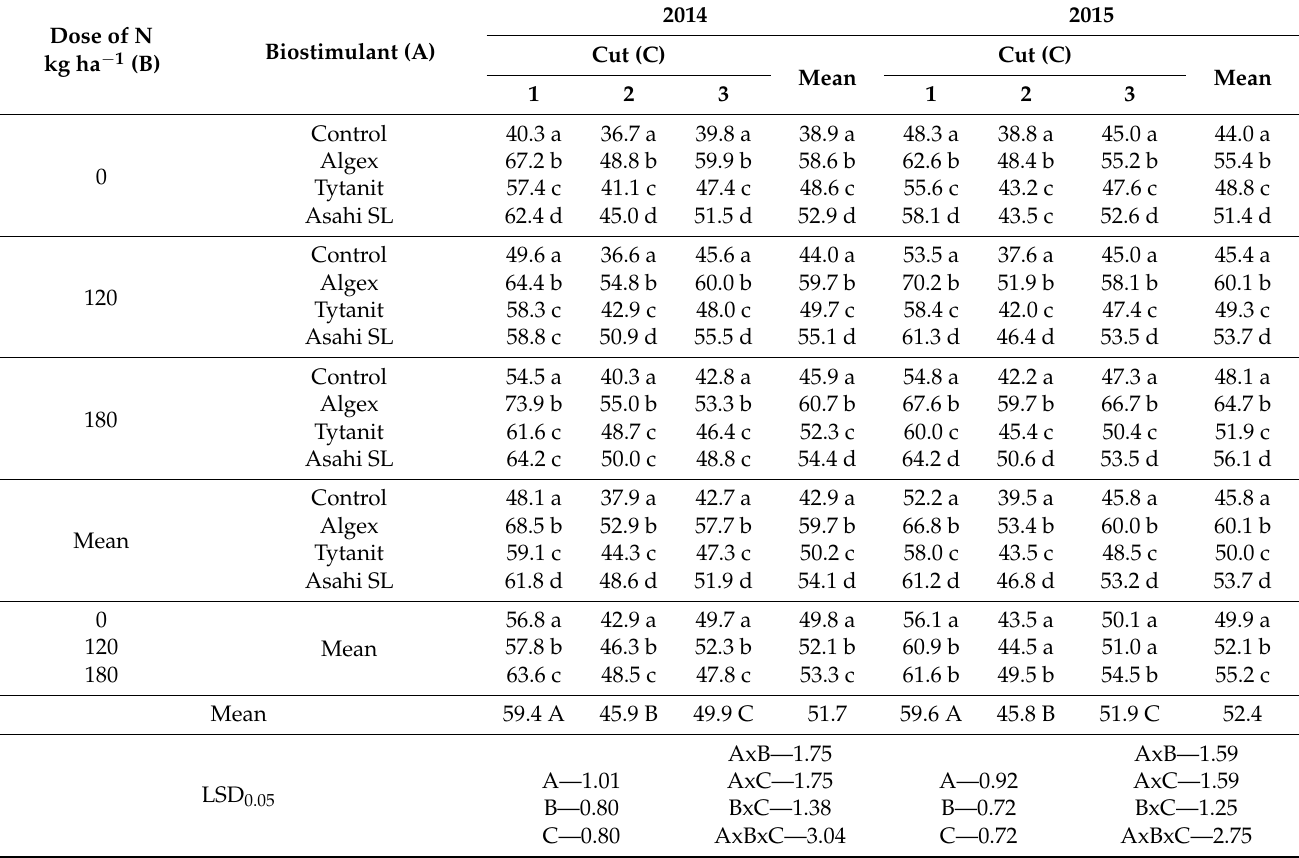
Table 5. The effect of the biostimulants on digestibility of Italian ryegrass (%) by cut and nitrogen fertilization. Dose of N Biostimulant kg ha − 1 (B)